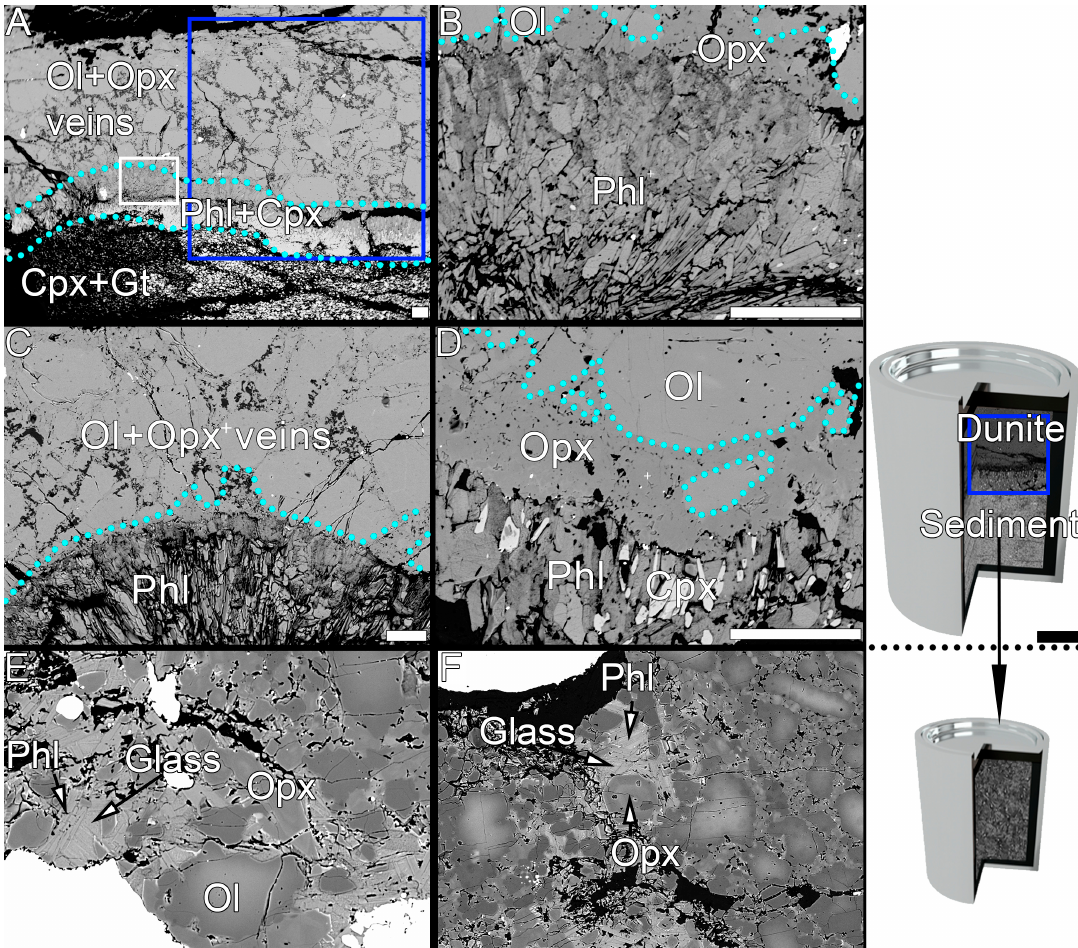
Figure 1. Backscattered electron images of reaction zones in high-pressure experiments. ( A ) Reaction experiment at 3 GPa/900 °C with dunite upper layer and sediment lower layer. Light blue dotted line highlights the extent of a 300–400 µm thick reaction zone composed of phlogopite and clinopyroxene. Blue square indicates the portion extracted for the second-stage experiment. ( B–D ) Close-ups of the upper part of the reaction zone (blue box in A). ( E ) and ( F ) Second-stage experiment in which the metasomatized dunite (blue square: reaction zone and dunite) of the experiment in ( A ) was melted at 2 GPa/1200 °C. All white scale bars ( A – F ) are 100 µm, while black scale bars for both capsules are 1 mm.